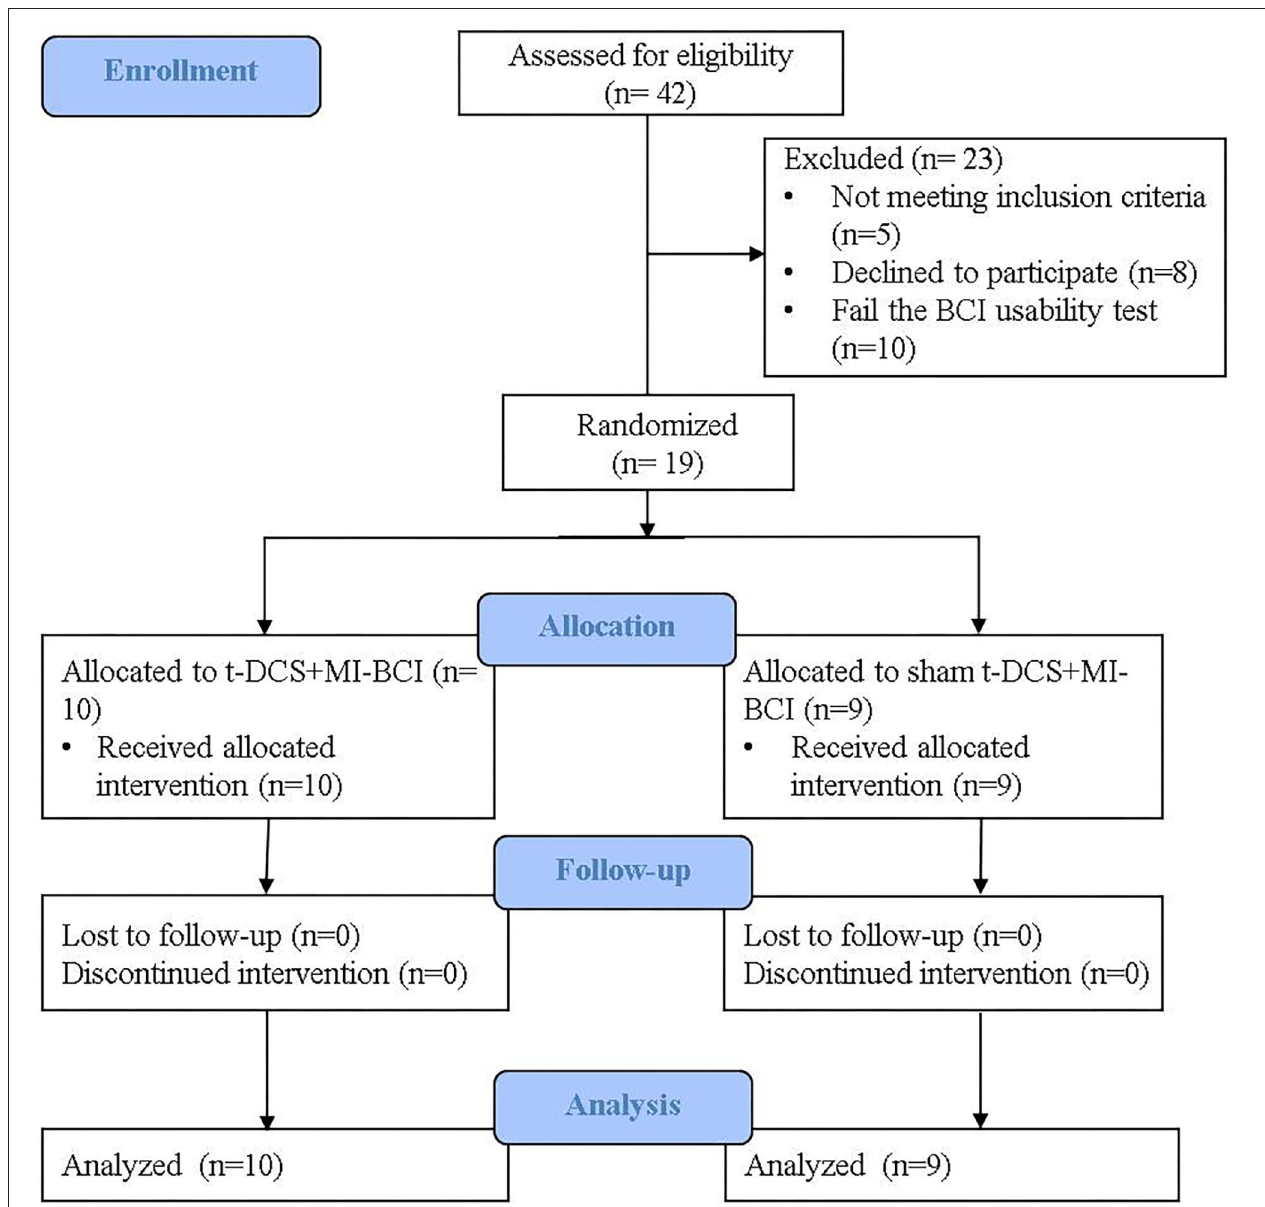
FIGURE 1 | CONSORT flow diagram. Forty-two participants were screened. Nineteen participants completed the intervention and follow-up evaluation and were included in the final analysis − 10 in the real-tDCS group, nine in the sham-tDCS group.